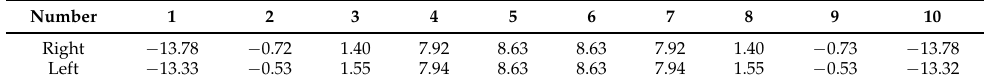
Table 4. The motion of air spring on right and left side of vehicle (mm).